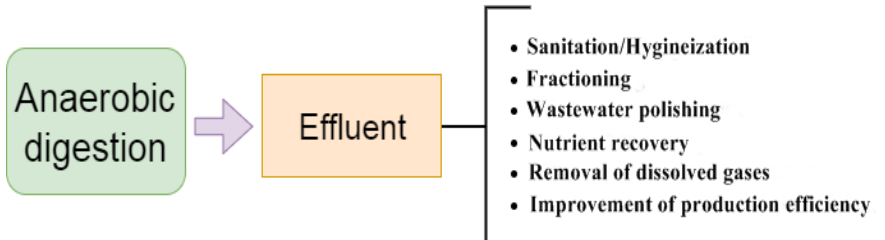
Figure 1. Potential roles of membranes in effluent treatment.